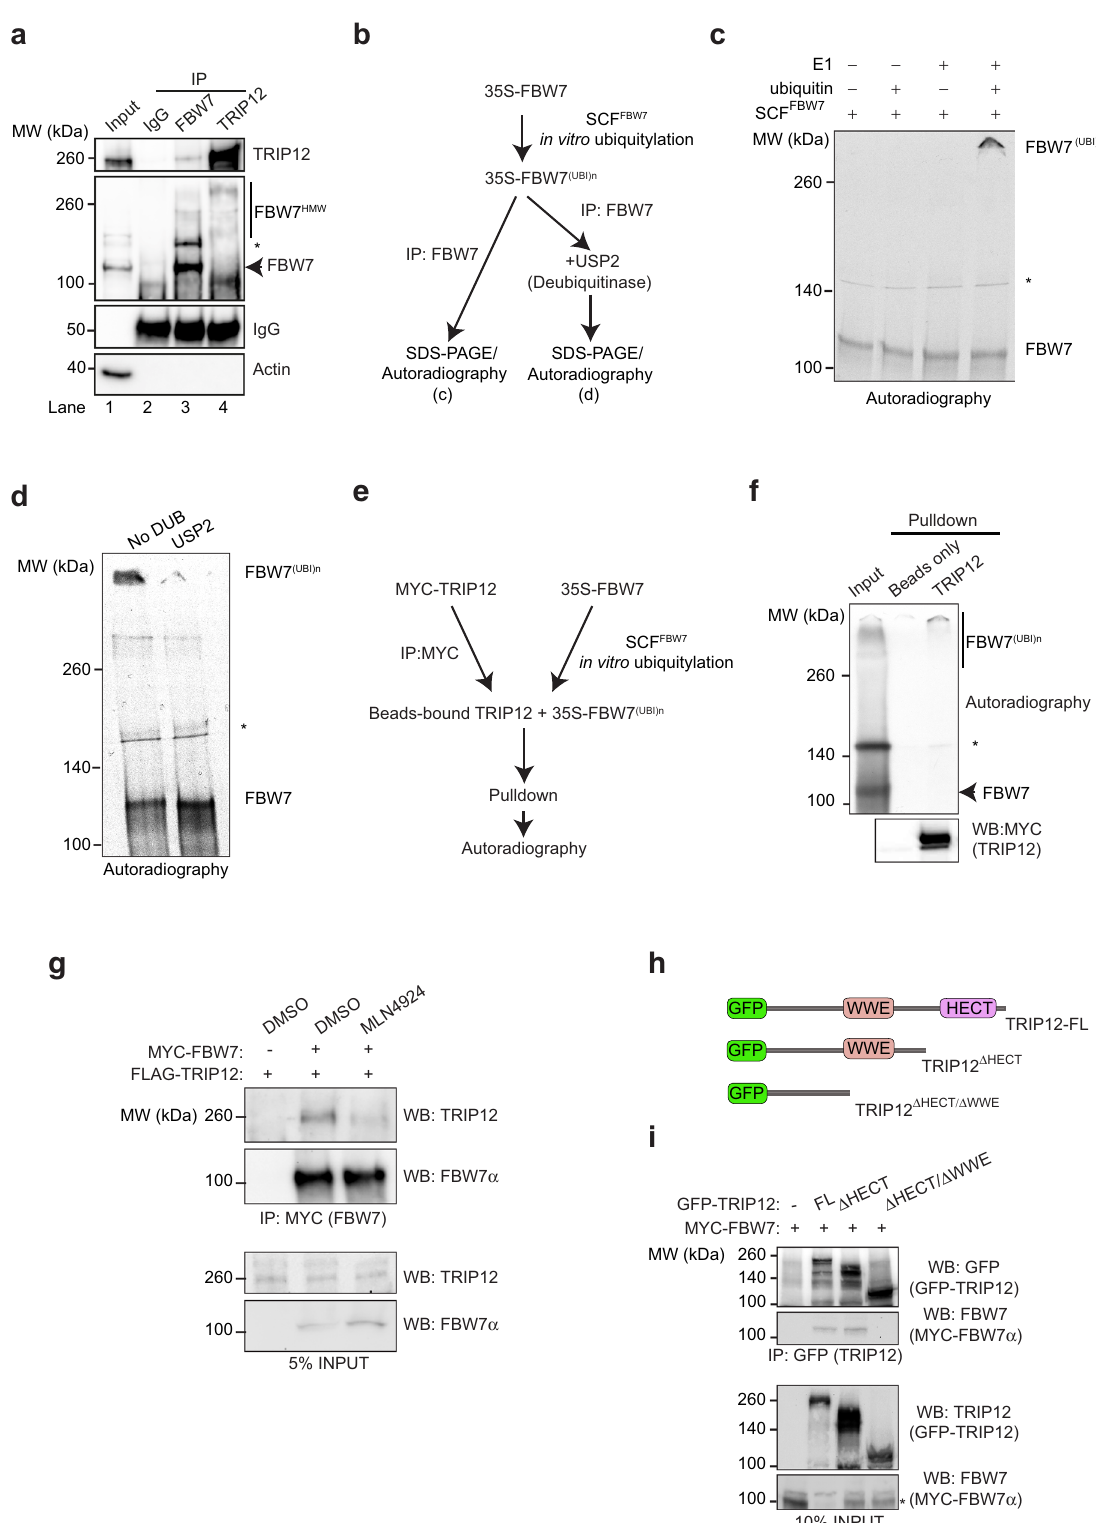
FBW7 binding to TRIP12 (Supplementary Fig. 4b and Fig. 4g), con fi rming the requirement of autoubiquitylation for ef fi cient FBW7 and TRIP12 interaction. To identify a potential ubiquitin- binding domain (UBD) in TRIP12, we incubated puri fi ed full- length beads-bound TRIP12 with unanchored di-ubiquitins of known topology and detected the loss of di-ubiquitins in